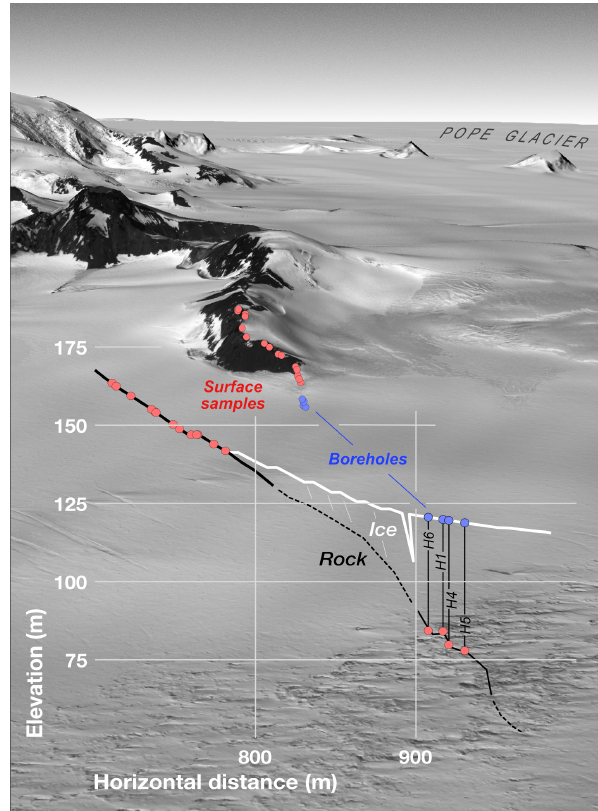
Figure 2. Synthetic oblique view of the drill site at the north ridge of Kay Peak generated from WorldView imagery (© 2018, Maxar) and the Reference Elevation Model of Antarctica (REMA) digital elevation model (Howat et al., 2019). View direction is to the south, as indicated in Fig. 1, from the position of a viewer located over the Crosson Ice Shelf and looking up Pope Glacier. The overlay is an elevation profile along the axis of Kay Peak Ridge showing the relationship between samples collected from the exposed portion of the ridge, drill sites, and subglacial bedrock samples. Note that the vertical scale of the inset profile excludes many samples collected from above 170m elevation on the ice-free portion of the ridge; Fig. 4 shows the elevation distribution of the entire sample